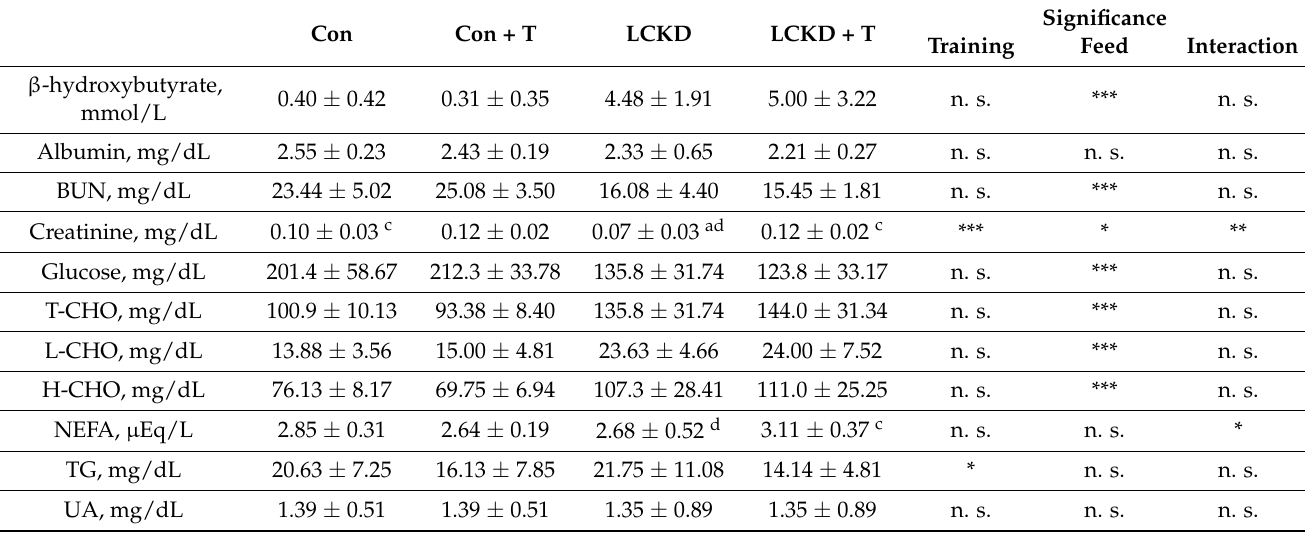
Table 4. The effects of LCKD feeding and/or training on plasma biochemical markers. Con Con + T LCKD LCKD + T